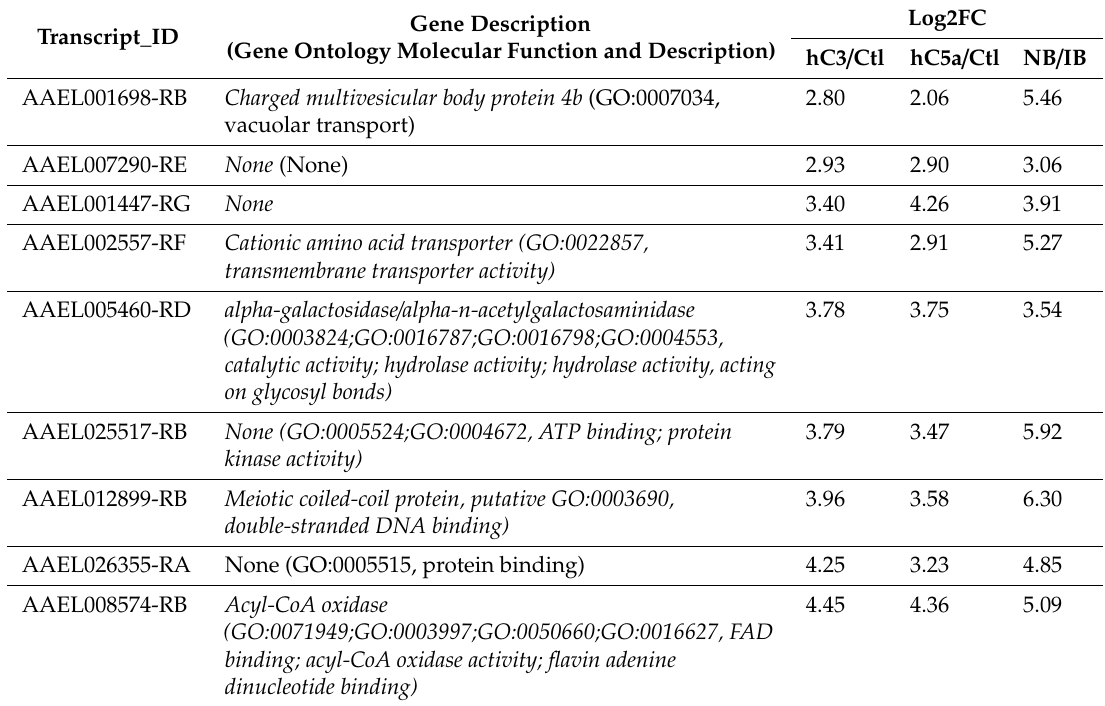
Figure 5. Differentially expressed protein-coding transcripts shared in response to both in vivo and in vitro experiments. Venn diagram of the up- ( A ) and downregulated ( B ) transcripts. The heatmap ( C ) shows the clustering of the 44 (21 up and 23 down) significantly regulated transcripts found in normal blood (NB), heat-inactivated blood (IB), and the in vitro experiments for treatments with hC3/hC5a and respective controls. Table 1. Forty-four shared differentially expressed protein-coding transcripts in response to treatment with human complement both in vivo and in vitro. The top of the table shows the upregulated (positive fold change (FC) values), and the bottom of the table shows the downregulated (negative FC) transcripts. Ctl denotes Aag2 untreated control cells.